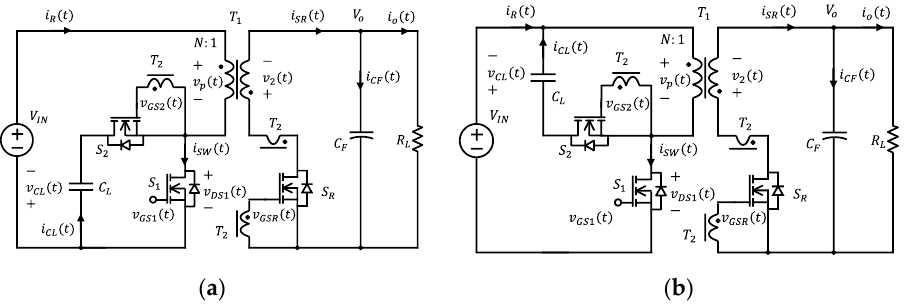
Figure 3. QR flyback DC – DC converter with SDAS: ( a ) QR flyback converter with SDAS in parallel with main switch; ( b ) QR flyback converter with SDAS in parallel with transformer.